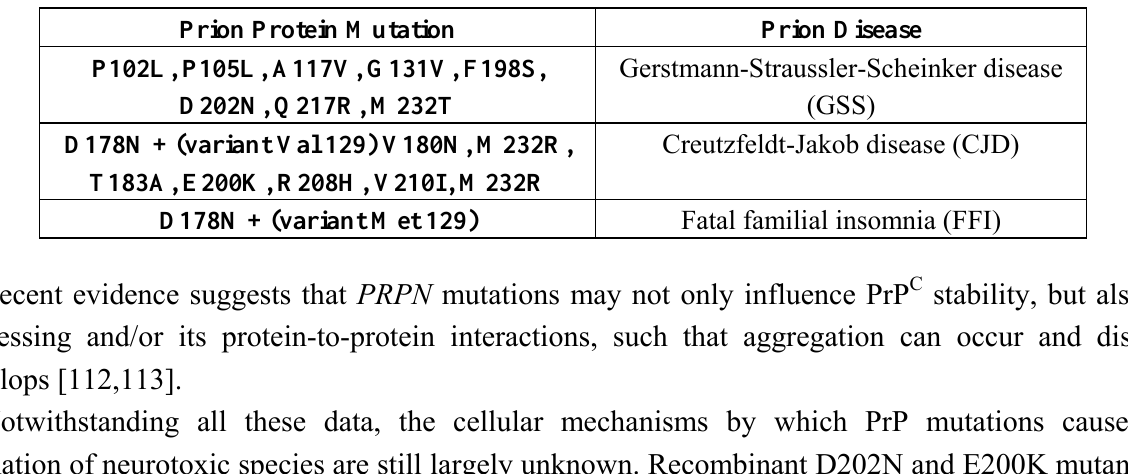
Table 2. Representative point mutations responsible of familial prion